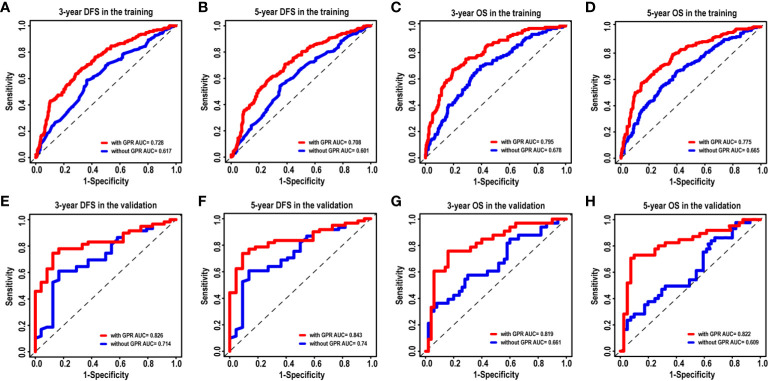
The ROC curves of the nomogram models with and without the GPR for HCC patients. (A–D) ROC curves showing the discriminatory abilities of the nomogram models with and without the GPR for the 3-year DFS (A) and OS (C) rates and 5-year DFS (B) and OS (D) rates in the training cohort. (E–H) ROC curves showing the discriminatory abilities of the nomogram model with and without the GPR for the 3-year DFS (E) and OS (G) rates and 5-year DFS (F) and OS (H) rates in the validation cohort. GPR, gamma‐glutamyl transpeptidase‐to‐platelet ratio; ROC, receiver operating characteristic; HCC, hepatocellular carcinoma; DFS, disease-free survival; OS, overall survival.